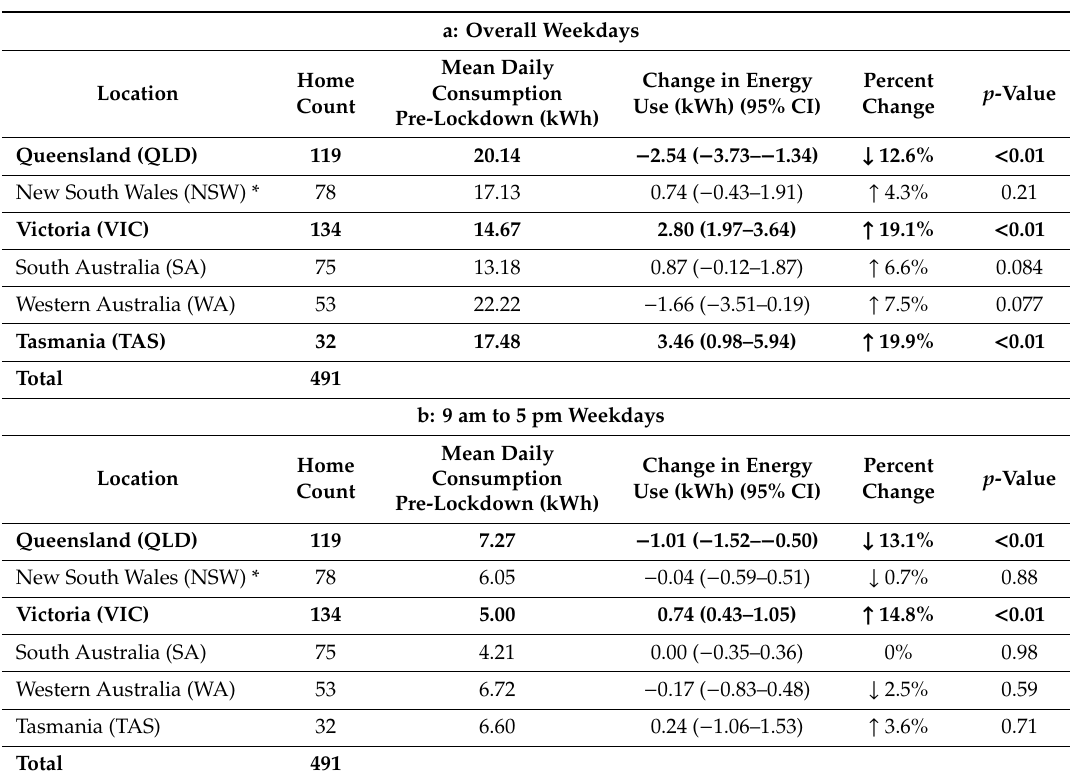
Table 3. (a,b): Significant changes in weekday energy use during COVID-19 lockdown (21 March to 8 May) relative to the period prior to lockdown (1 February to 19 March) from smart inverter data, overall use during weekdays (a) and weekdays 9 am to 5 pm only